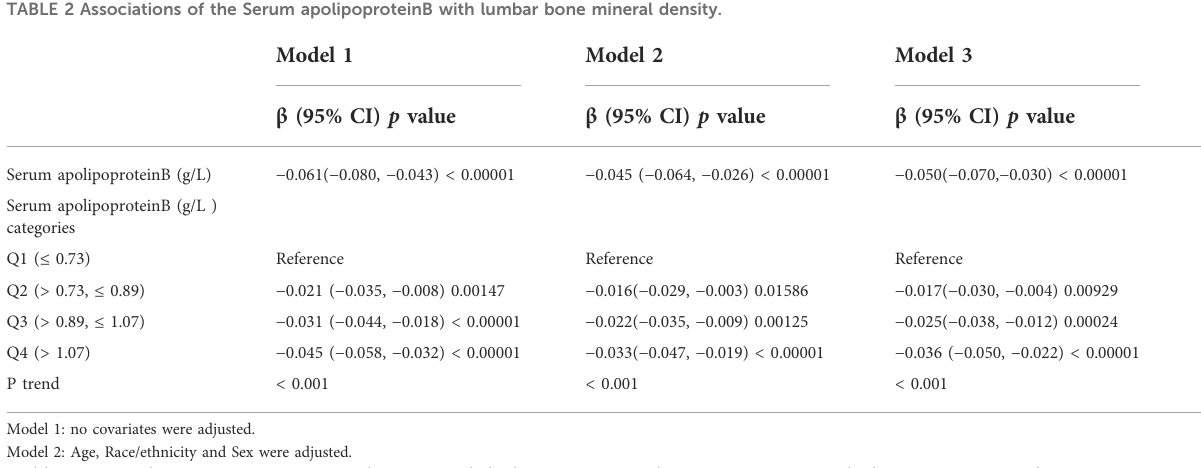
TABLE 2 Associations of the Serum apolipoproteinB with lumbar bone mineral density.